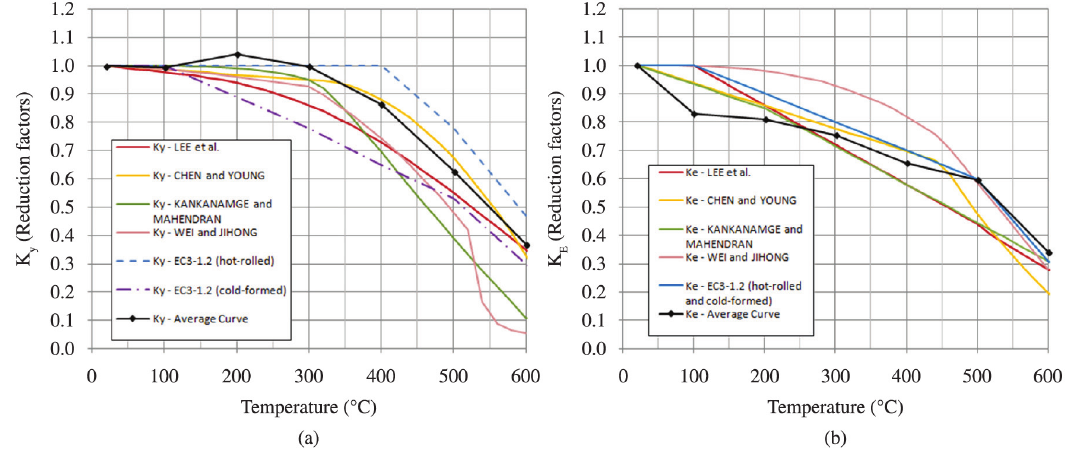
Figure 8. Reduction factors according with temperature variation: (a) yield strength K